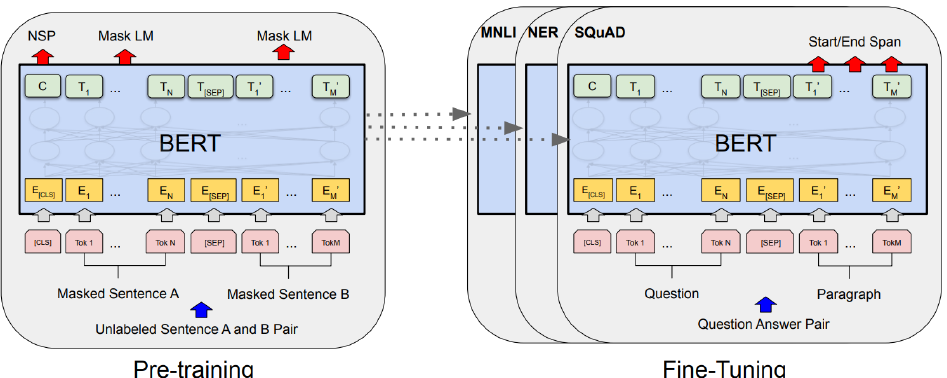
Figure 2. The BERT architecture [20] in a pre-training context ( left ) or fine-tuning for different tasks ( right